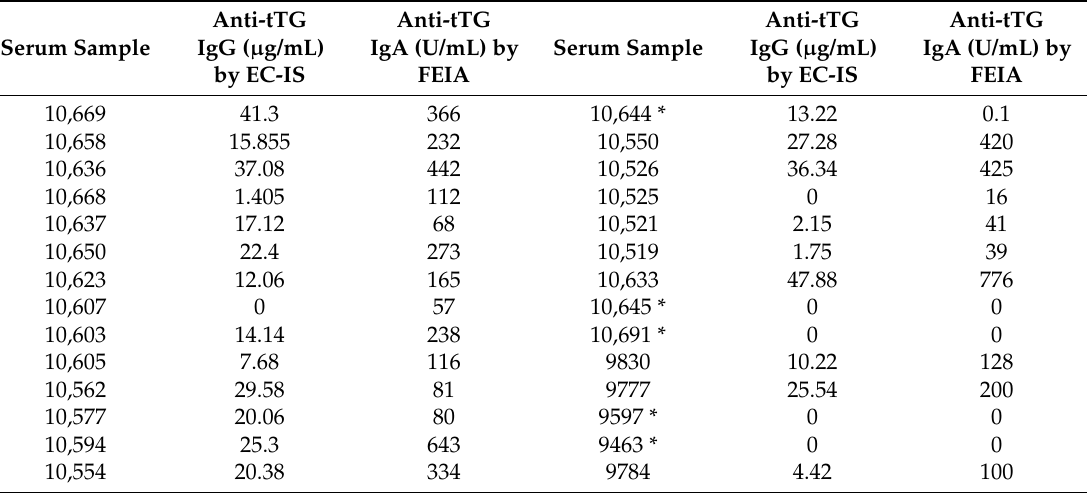
Table 1. Average anti-tTG IgG and IgA concentrations determined by the proposed electrochemical immunosensor (EC-IS) and clinical fluoroenzyme immunoassay (FEIA) methods, respectively.